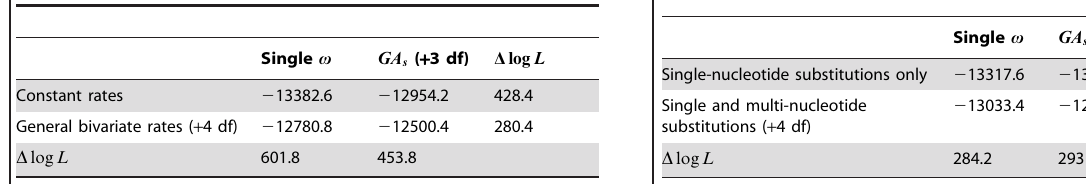
Table 5. The effects of modeling site-to-site rate variation and multiple non-synonymous rates in the vertebrate rhodopsin alignment using the MG frequency parameterization.